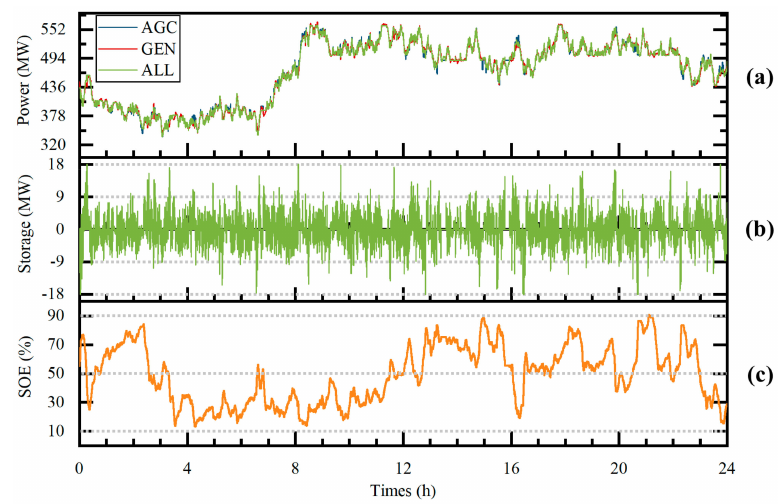
Figure 7. The simulation results of the 3 MWh energy storage system: ( a ) Power, ( b ) Storage, and ( c )